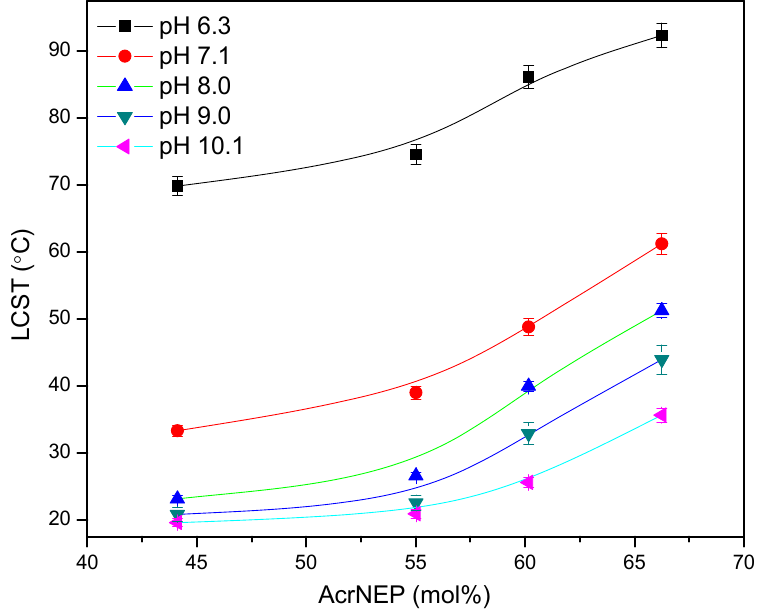
Figure 3. Effect of copolymer composition and solution pH on the